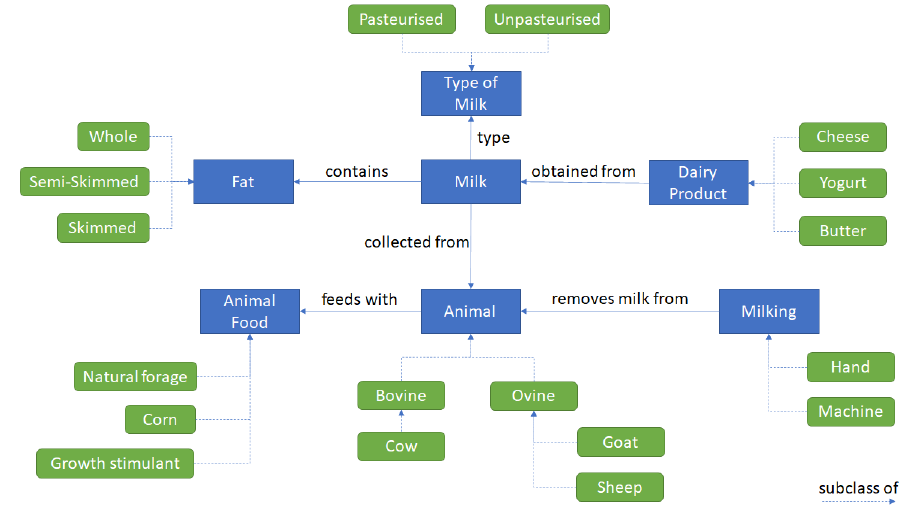
Figure 1. DF ontology.